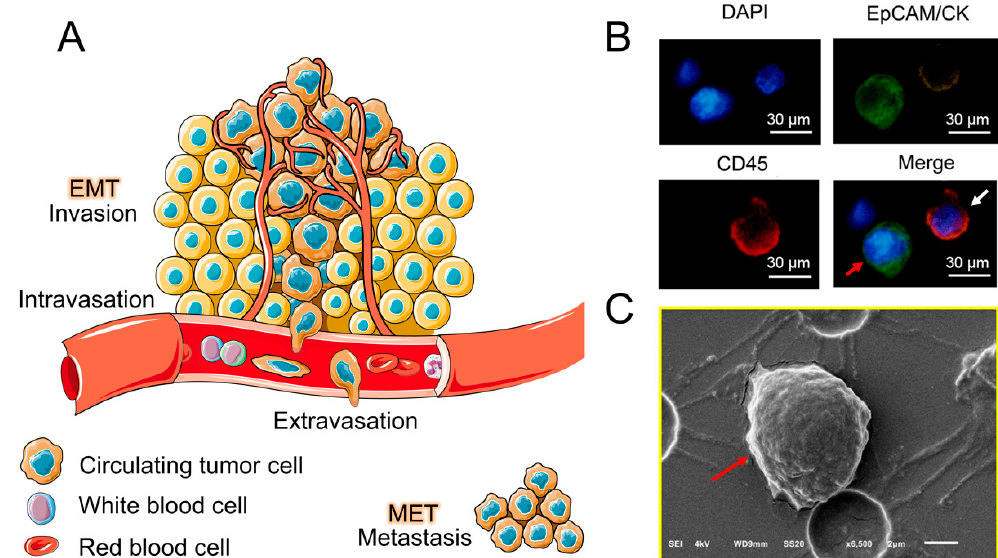
Figure 1 . The biological properties of CTC. ( A ) A schematic diagram of the four stages of tumor metastasis formation, which is invasion, intravasation, extravasation and metastasis. ( B ) Fluorescence image of CTC (red arrow) and WBC (white arrow), cells were stained with DAPI, EpCAM/CK and CD45 (Scale bars = 30 μ m) [54]. ( C ) Scanning electron micrograph of CTC (red arrow) (Scale bar = 2 μ m) [55].